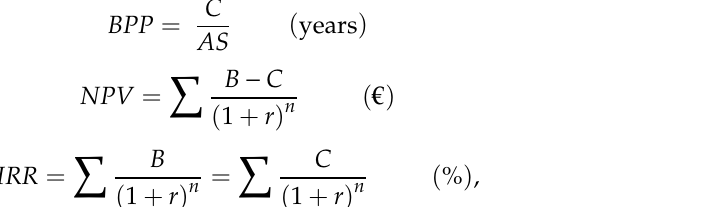
Table 5. Economic analysis results.